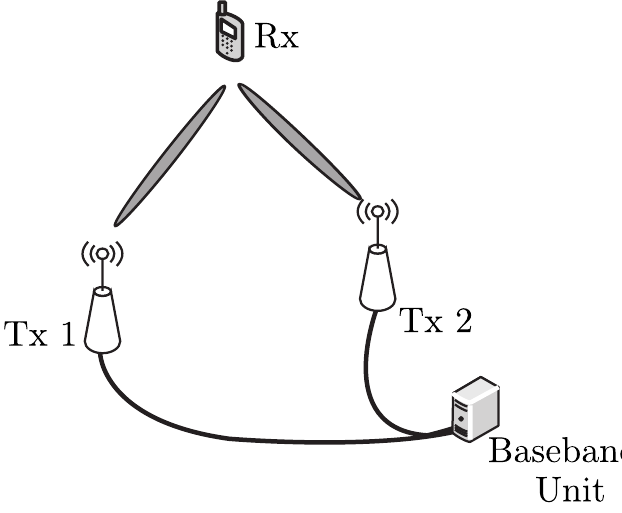
Figure 1. An example illustration of a distributed antenna system